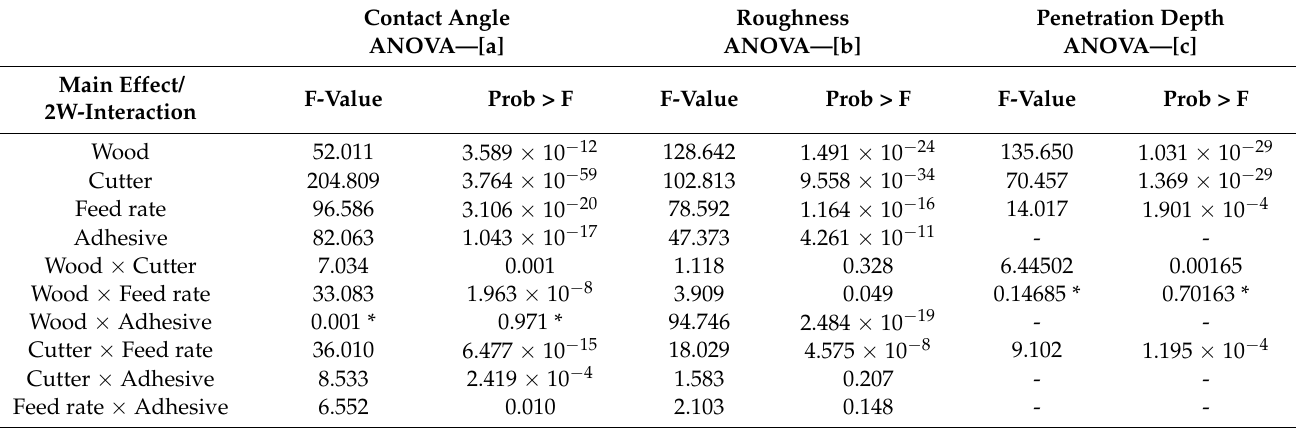
Table 3. ANOVA results table (sig. level 0.05) based on the Full Factorial Designs from Table